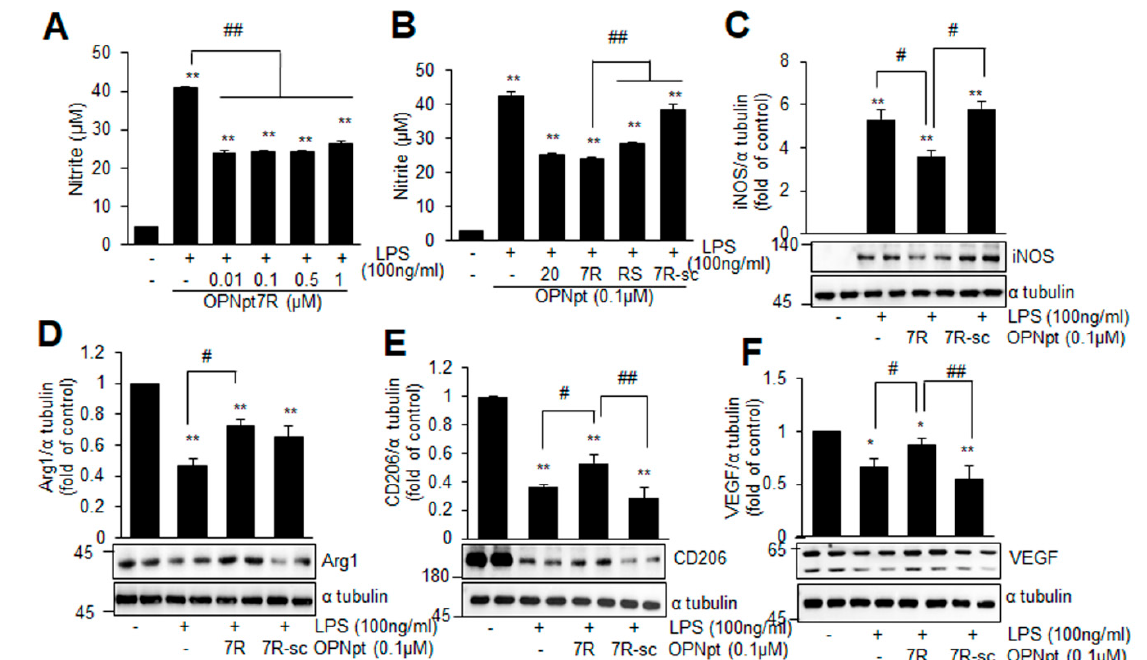
Figure 4. Anti-inflammatory effect of OPNpt7R in primary microglial cultures; ( A , B ) primary microglial cultures were pre-incubated with OPNpt7R (0.01, 0.1, 0.5 or 1 µM) for 1 h ( A ) or with 0.1 µM of OPNpt20, OPNpt7R, OPNpt7RS, or OPNpt7R-sc for 1 h ( B ) and treated with LPS (100 ng/mL) for 24 h. Nitrite production was measured using the Griess assay. ( C , D ) Primary microglial cultures were pre-incubated with 0.1 µ M of OPNpt7R or OPNpt7R-sc for 1 h and treated with LPS (100 ng/mL). Levels of proinflammatory (iNOS) ( C ) or anti-inflammatory (Arg1, CD206, and VEGF) ( D – F ) markers were determined by immunoblotting, and the results are presented as the mean ± SEM ( n = 3–6). * p < 0.05, ** p < 0.01 versus LPS-treated cells, # p < 0.05, ## p < 0.01 between indicated groups.